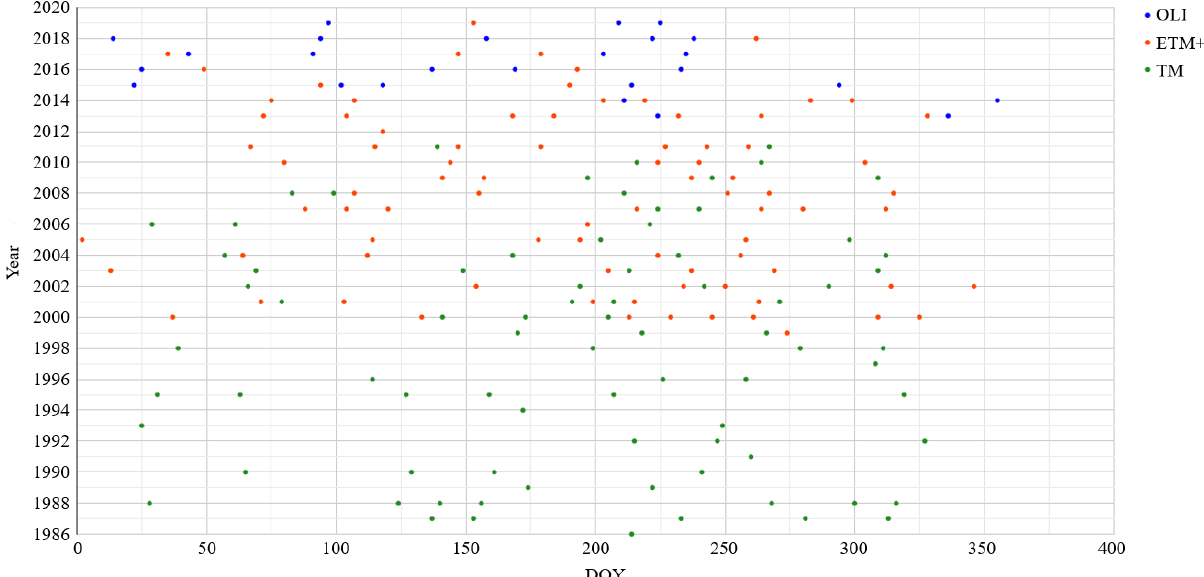
Figure 6. Time Distribution of history archive data of Landsat TM, ETM+ and OLI at Cloud Coverage threshold <=30% over one scene (path/row:127/39) footprint. (DOY means the day of